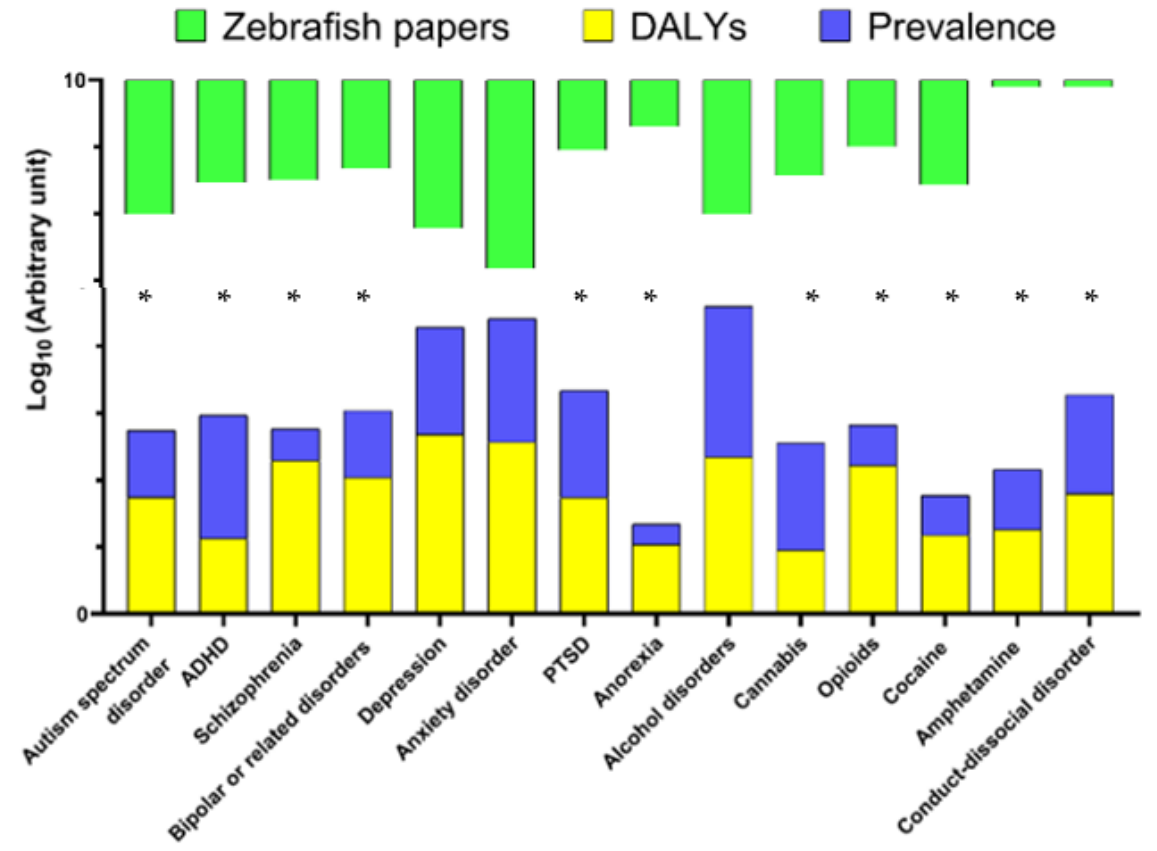
Figure 2. Graphical representation of the number of publications using zebrafish as animal model for various CNS disorders relative to their clinical prevalence in adults, and global burden (DALYs). Areas (denoted by asterisks) with bigger gaps between the bars indicate CNS disorders for which the amount of current clinical and zebrafish evidence does not match, hence meriting further translational modeling efforts.